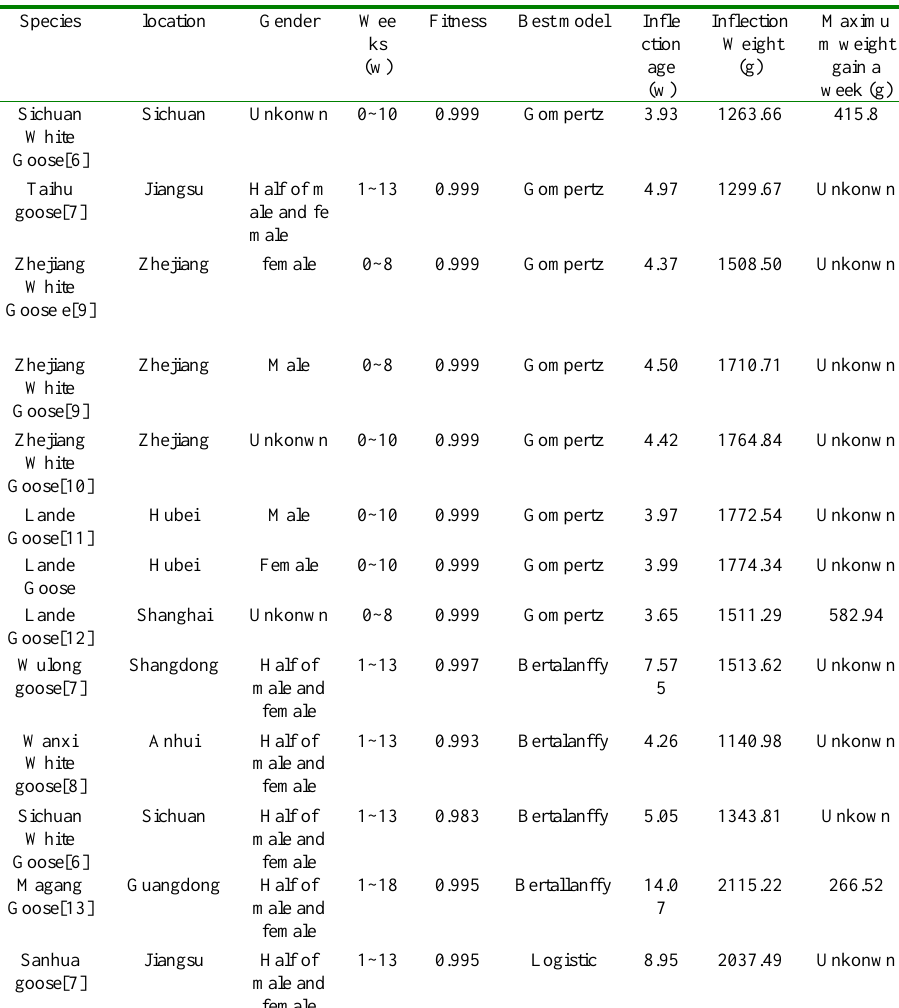
Table 2. Growth curve fitting analysis in